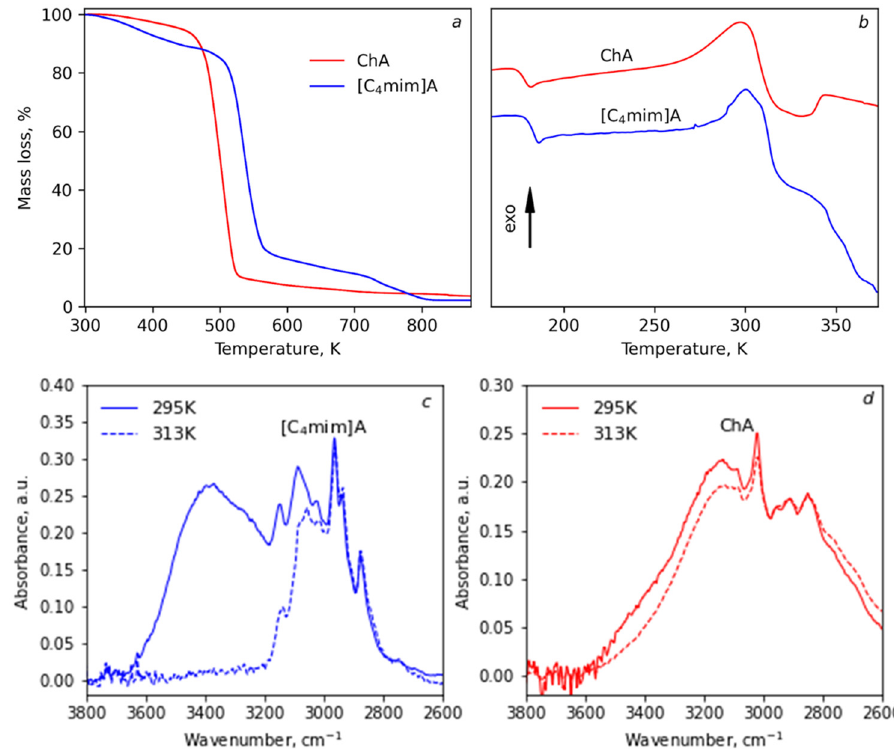
Figure 3. TGA curves ( a ), DSC curves ( b ), and FTIR spectra of [C 4 mim]A ( c ) and ChA ( d ).